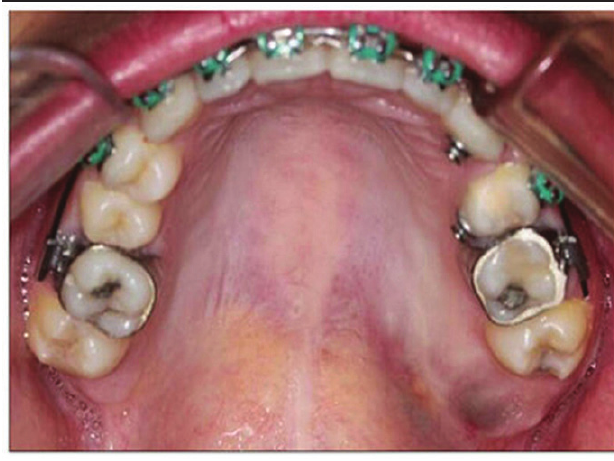
figurE 1 − Intra-oral examination: expansive lesion in left posterior palate